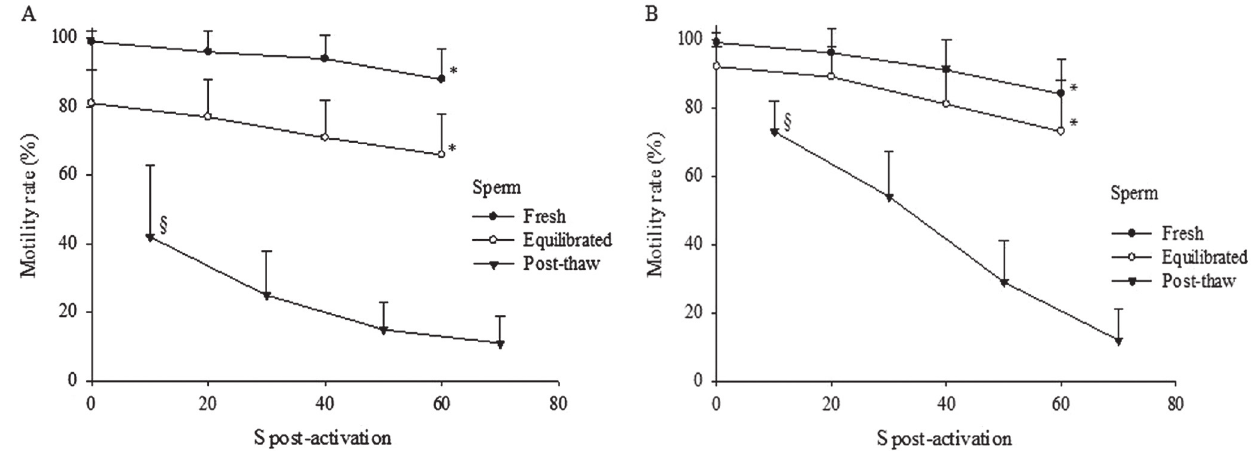
Fig. 1. Motility rate of fresh, equilibrated and post-thaw sperm of Brycon orbignyanus (A; n = 18 males) and Prochilodus lineatus (B; n = 21 males). Motility rate was evaluated after 0, 20, 40 and 60s (fresh and equilibrated sperm) or after 10, 30, 50 and 70s of activation (post-thaw sperm). * Motility evaluated at 60s was lower than that at 0s post-activation (Scott-Knott, P < 0.05). § Motility evaluated at 10s post-activation was the highest (Scott-Knott, P <